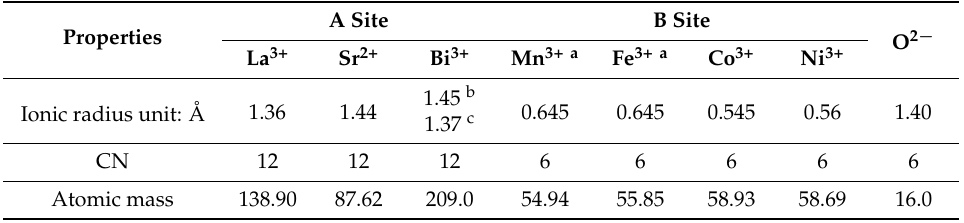
Table 5. Ionic radii of cation used for calculation of the geometry factors [39].